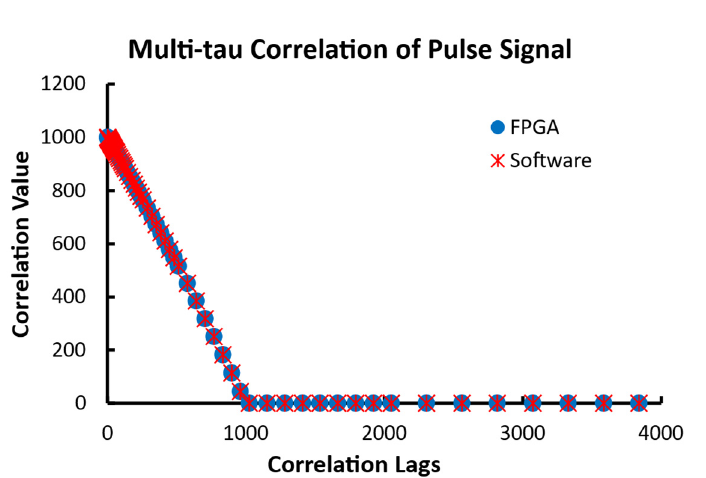
Figure 16. The outputs of 80 correlation lags of a pulse with 1000 data points of value 100 followed by 9000 zeros from the multi-tau FPGA correlator and the software correlator. The correlation lag doubles every 8 lags after the initial 16 lags.